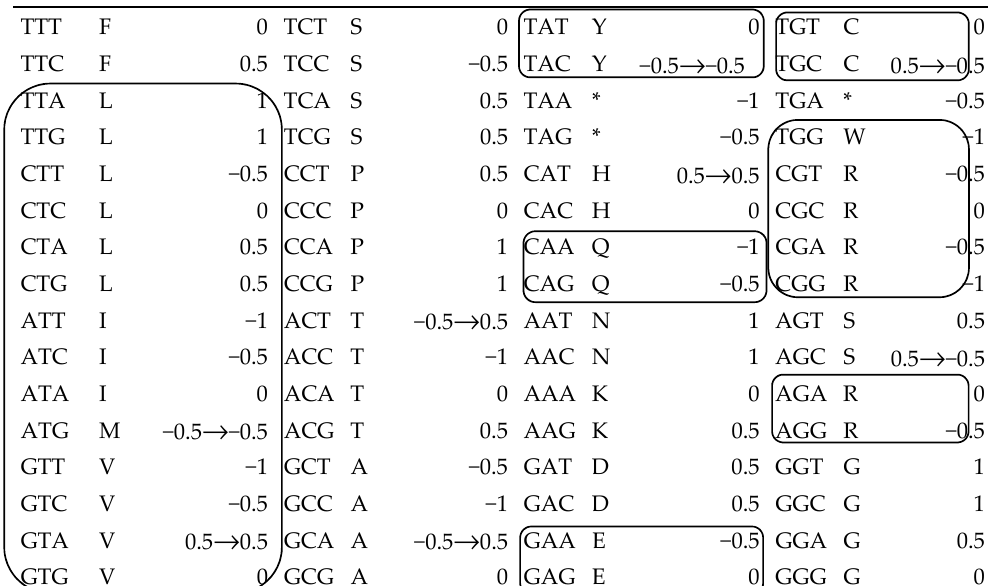
0.5 0 GCG A 0 GAG E 0 GGG G 0 This produces a negative mean CDA for codons coding for Cys, in line with the overall tendency for negative CDA for amino acids aminoacylated by class I tRNA synthetases. The sign of mean CDA for other synonymous codon classes remains unchanged. Hence, this new rule for completing CDA improves the correlation between CDA and tRNA synthetase class, with 17 among 20 (85%) amino acids fitting the observed patterns (from p = 0.00295 to p = 0.000644, one tailed sign test, according to a binomial distribution assuming equal chances for negative and positive mean CDA to match class I and II tRNA synthetases). These new CDA scores also produce stronger correlations with antiparallel beta sheet indices (from r = − 0.642, one tailed p = 0.00114, to r = − 0.694, one tailed p = 0.000344) and with the genetic code inclusion order according to the self-referential model (from r